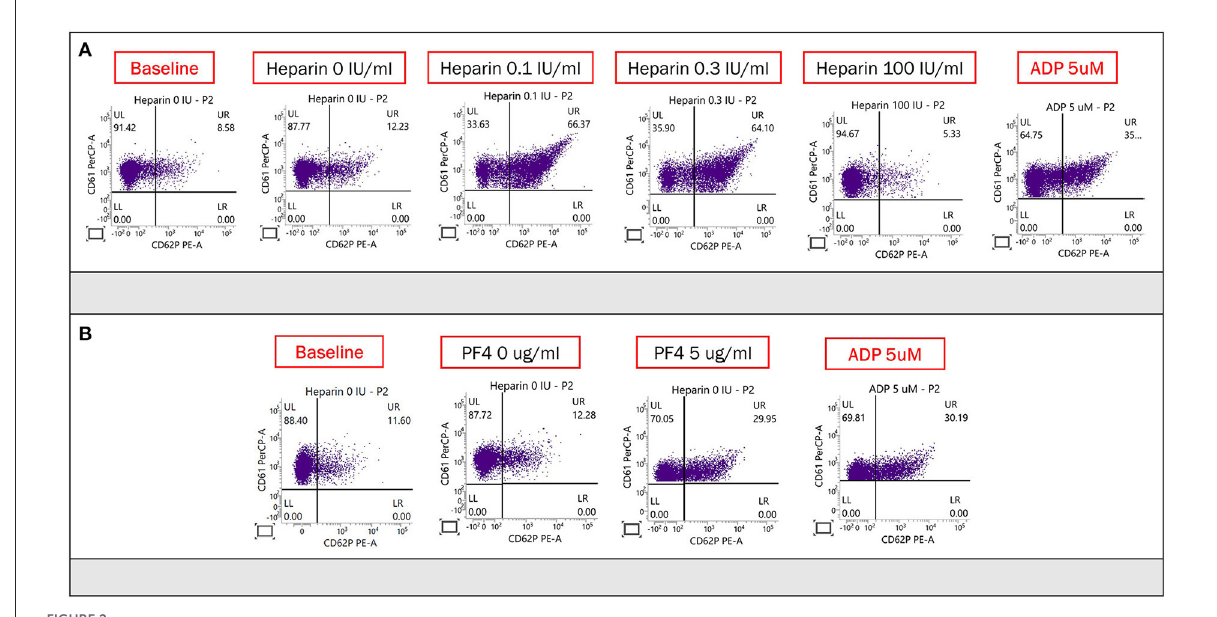
FIGURE2 (A) Heparin-induced platelet activation assay was used to detect of HIT antibodies. CD61 (glycoprotein IIIa) and CD62p (p-selectin) served as markers of platelet identification and activation, respectively. Adenosine diphosphate was used to confirm normal platelet activation. The proportion of activated platelets was at least > 11% in the presence of heparin (0.1 or 0.3 IU/ml) compared with baseline (no heparin), and the activation could be suppressed by a high dose of heparin (100 IU/ml). There was obvious platelet activation in the presence of the patient’s plasma and low concentration (0.1 and 0.3 U/ml) of heparin, which was suppressed by the high concentration of heparin (100 U/ml). (B) PF4-induced flow cytometry-based platelet activation (PIFPA) revealed that the percentage of activated platelets increased from 12.28% baseline, no PF4 addition) to 29.95% with addition of 5 µ g/ml